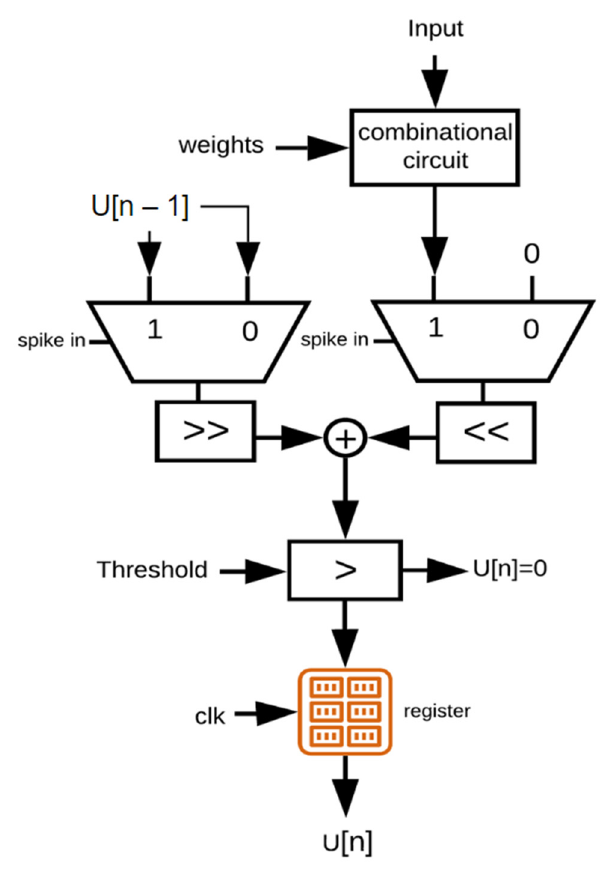
Figure 3. The data flow graph of a simplified LIF neuron includes a combination circuit for synaptic multiplication, two multiplexers for increasing and decreasing the membrane potential, two shifters, an adder for multiplication and division, and a comparator for generating output spikes.